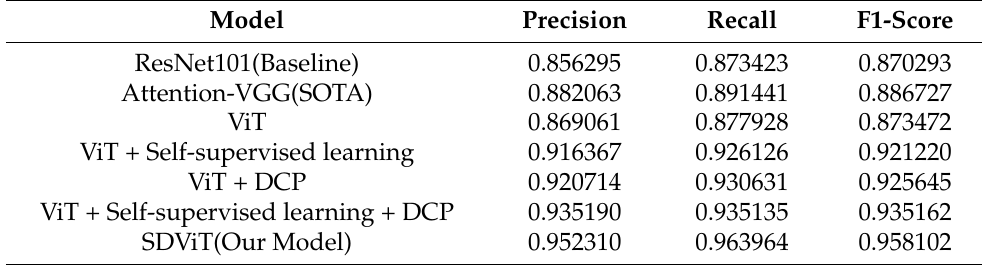
Table 8. Statistical metrics of different model configurations on X-ray Image dataset.